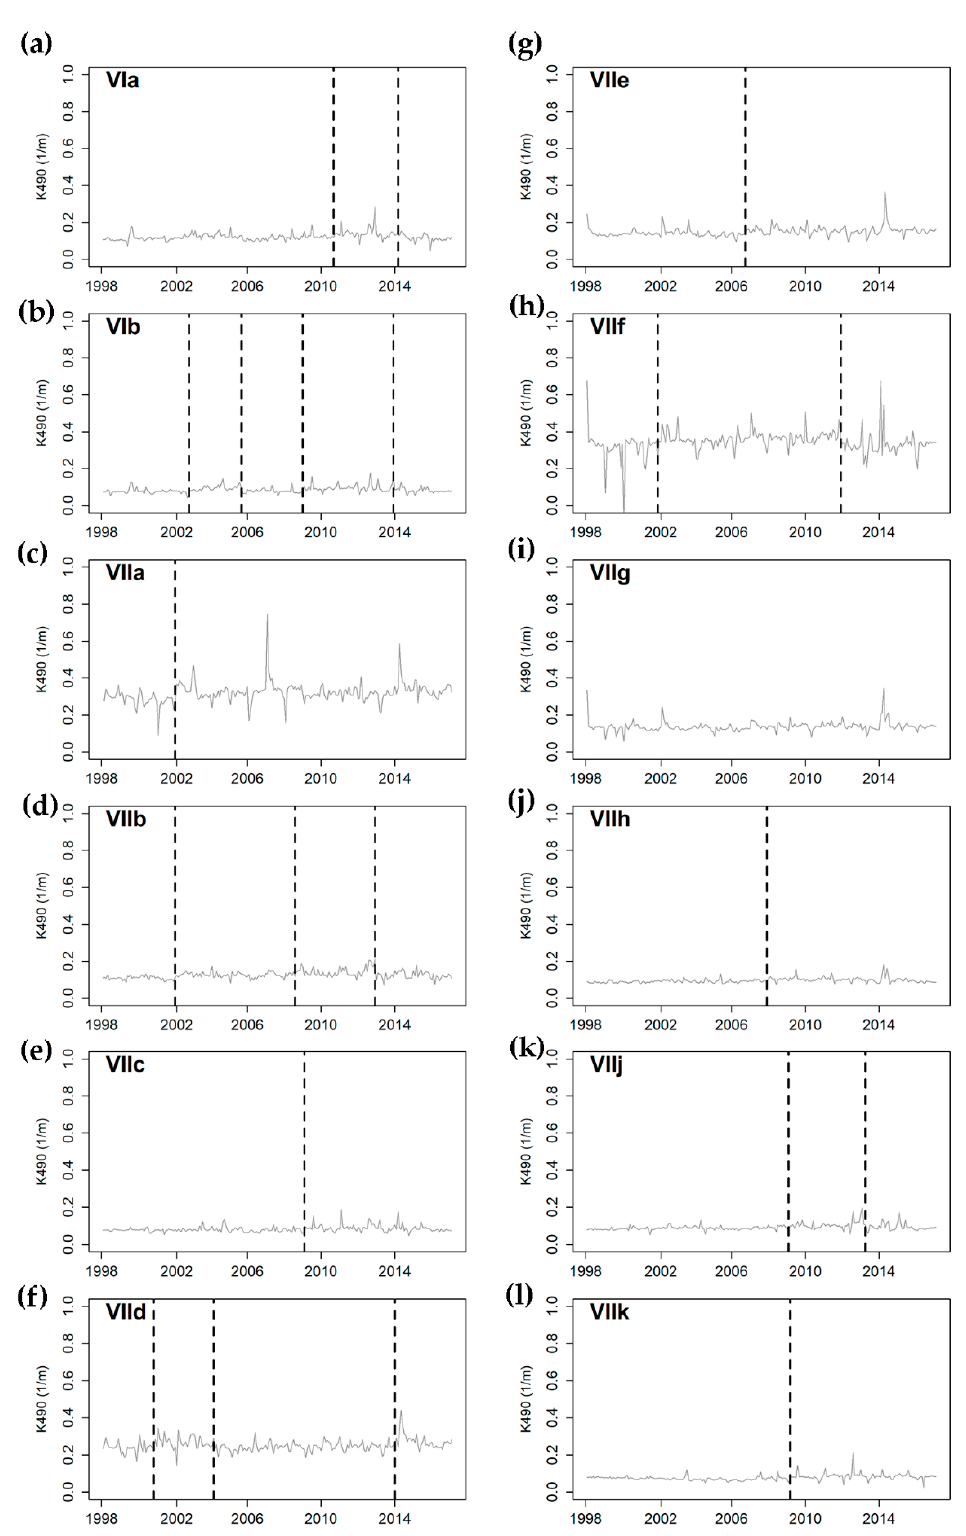
Figure 7. Seasonally adjusted K490 time series for each ICES division. Structural breakpoints were